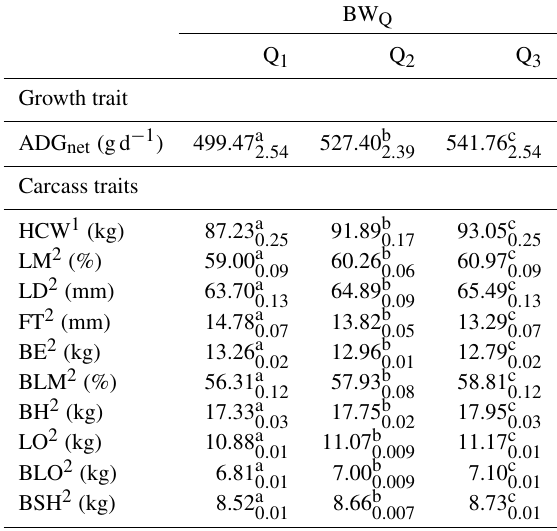
Table 5. LSQ mean (with SE as index) of the significant interac- tions between sire line and sex for growth traits and carcass traits.